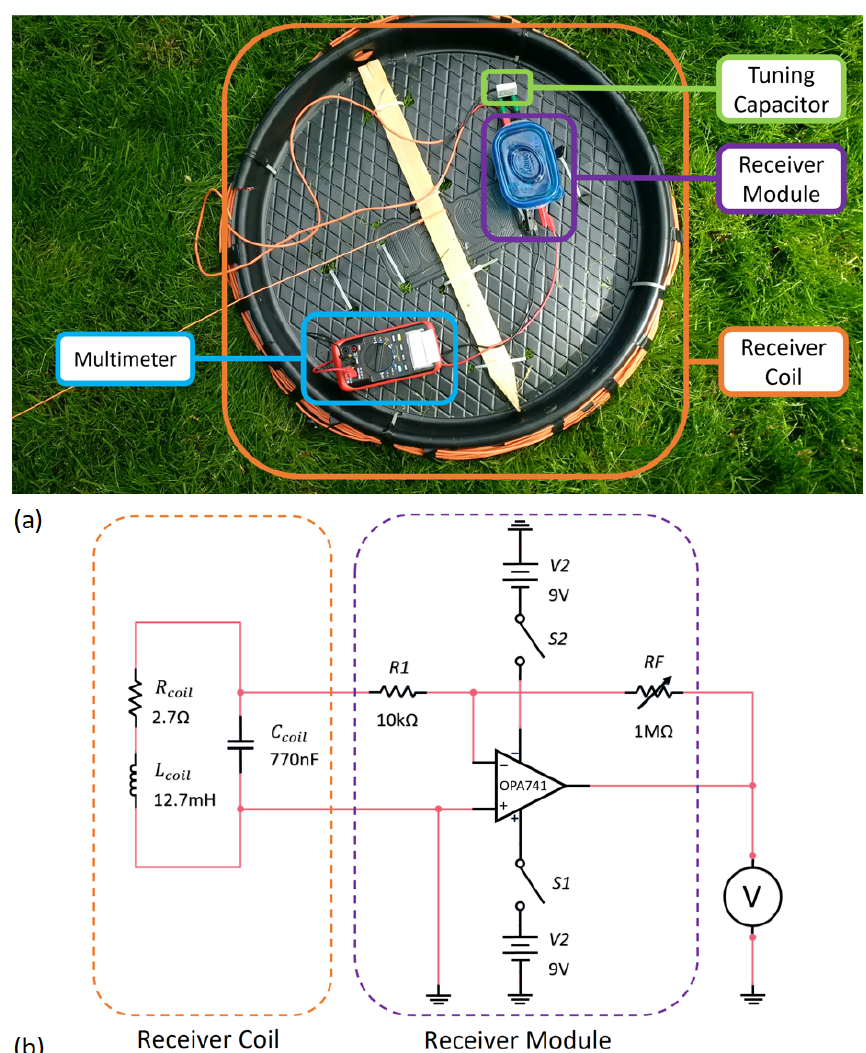
Figure 6. (a) Low-cost CSM-EM R x system. The R x coil (with attached tuning capacitor C coil ) acts as an RLC bandpass filter for a given frequency. The signal is passed through an inverting amplifier and an RMS voltage is measured by a DMM. (b) Low-cost CSM-EM R x circuit diagram consisting of the R x coil/tuning capacitor, an OPA741 inverting amplifier powered by two 9V batteries, and a DMM. Two single pole switches are attached to the batteries to prevent unwanted power drain. The switches are not intended to function independently and can be replaced with one double pole switch; however, single pole switches are more widely available in most